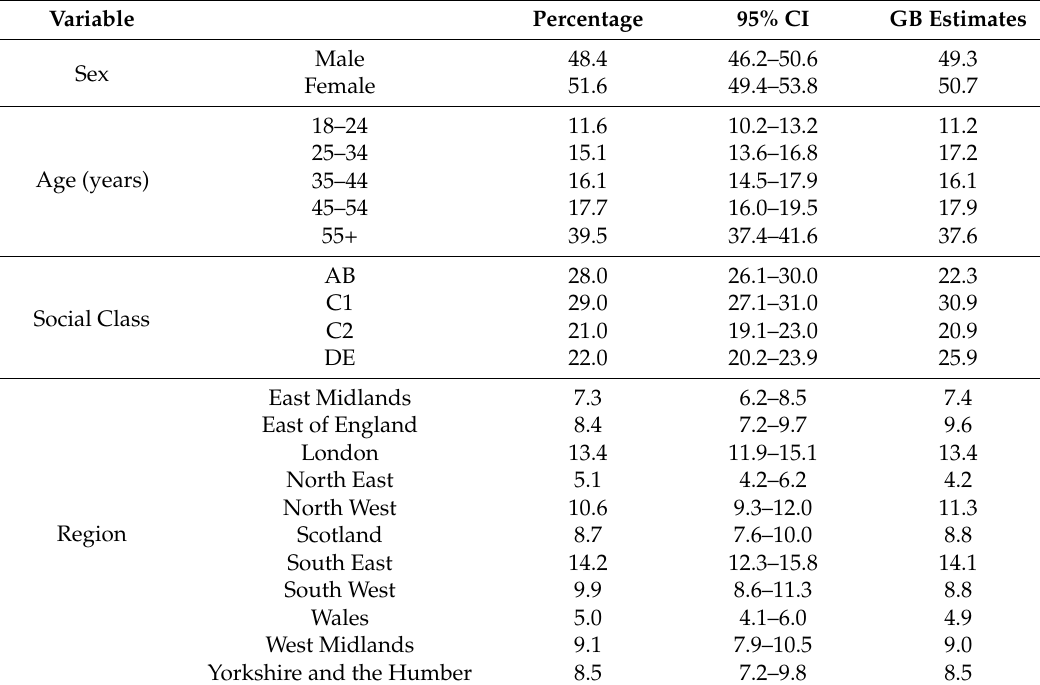
Table 1. Descriptive statistics of adult participants.